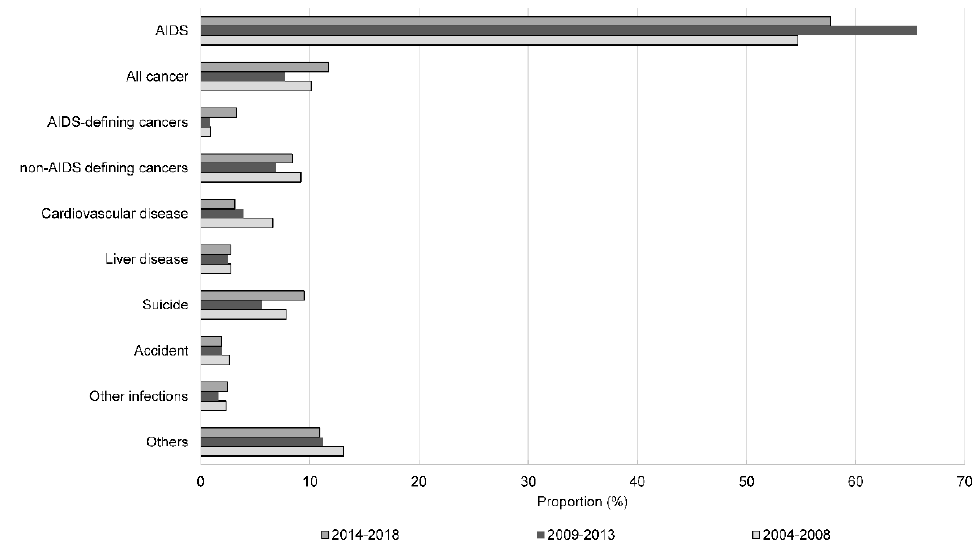
Figure 2. Distribution of the causes of death among individuals with human immunodeficiency virus (HIV) in Korea, 2004–2018.